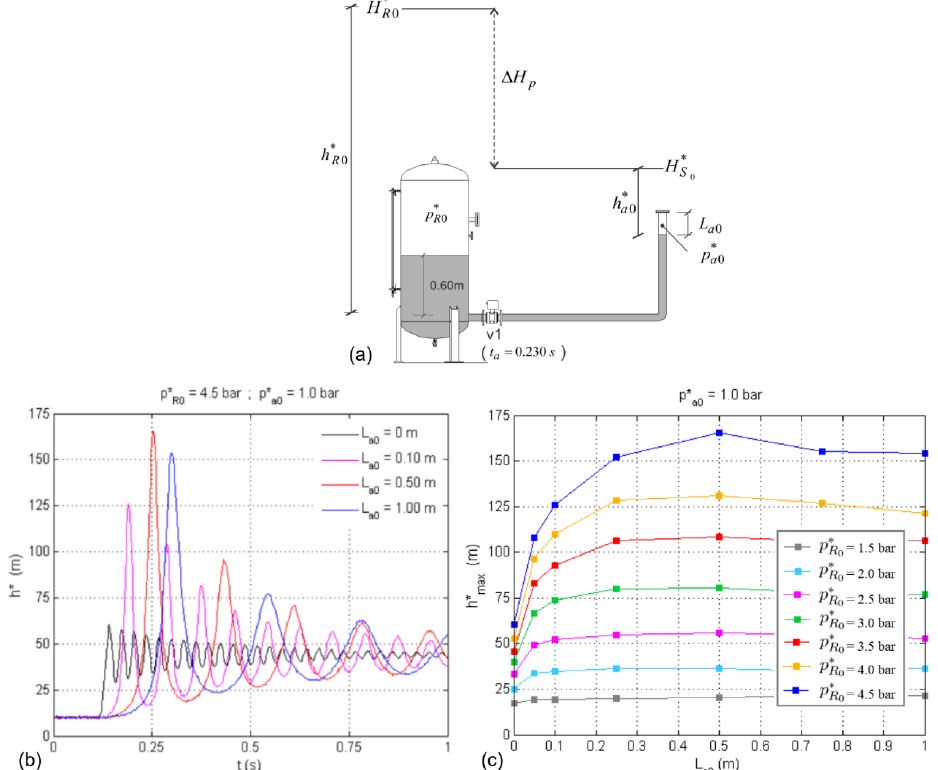
Figure 1. Pipeline filling tests for system with confined entrapped air pocket: ( a ) experimental apparatus; ( b ) piezometric head variation; ( c ) maximum piezometric